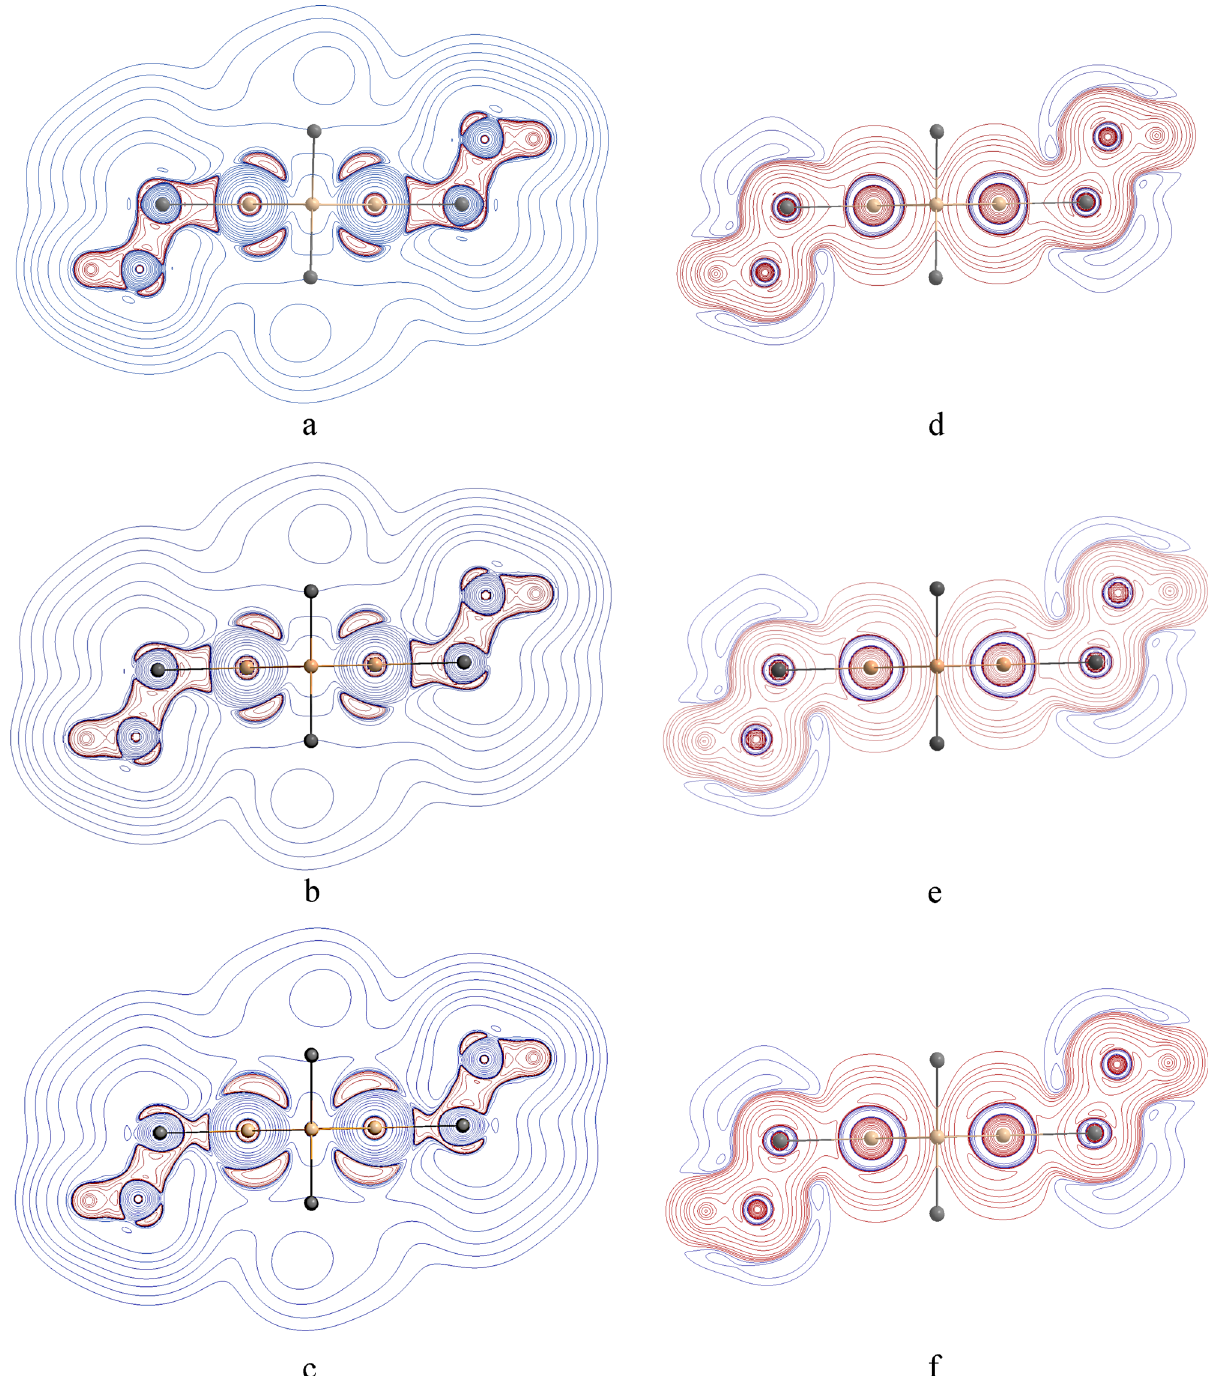
Fig. 2 Topology of the derivitives of the electron density. Topology of the derivitives of the electron density; contour plots of the Laplacian of electron density ( a – c ) and energy density ( d – f ) in 2 . CH 3 groups are removed for more clarity in the plot. Positive and negative values are represented by blue and red lines, respectively. a The central region between 1,3 atoms has a positive Laplacian that is a sign of closed-shell interaction. b By removing electrons from the σ -bonding HOMO − 6 the electron density concentrations, corresponding to the p- atomic orbitals on the Si atoms intensi fi es. c Removing all electrons from the σ -framework of Si 4 intensi fi es the p -electron density concentration. d Contour plot of energy density that shows a covalent-type interaction between Si atoms. e Contour plot of energy density after removing electrons from HOMO − 6, and ( f ) after removing electrons from all σ -MOs of Si 4 moiety. The p-atomic orbital-shaped feature appears on the Si atoms by removing the σ -electrons in the contour plot of energy density